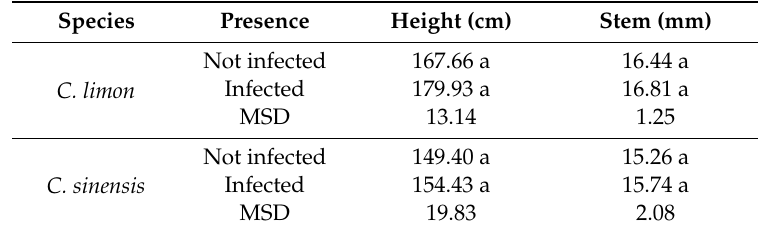
Table 3. Plant height and stem diameter of uninfected and infected C. limon and C. sinensis plants.